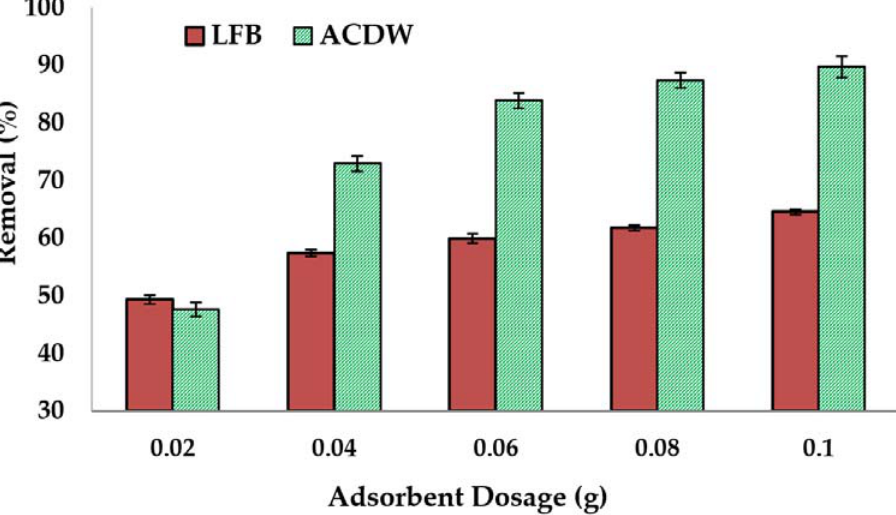
Figure 6. Influence of adsorbent dosage on the treatment of ammonia using whole biomass (ACDW) and lipid ‐ free biomass (LFB) of Arthrospira platensis .